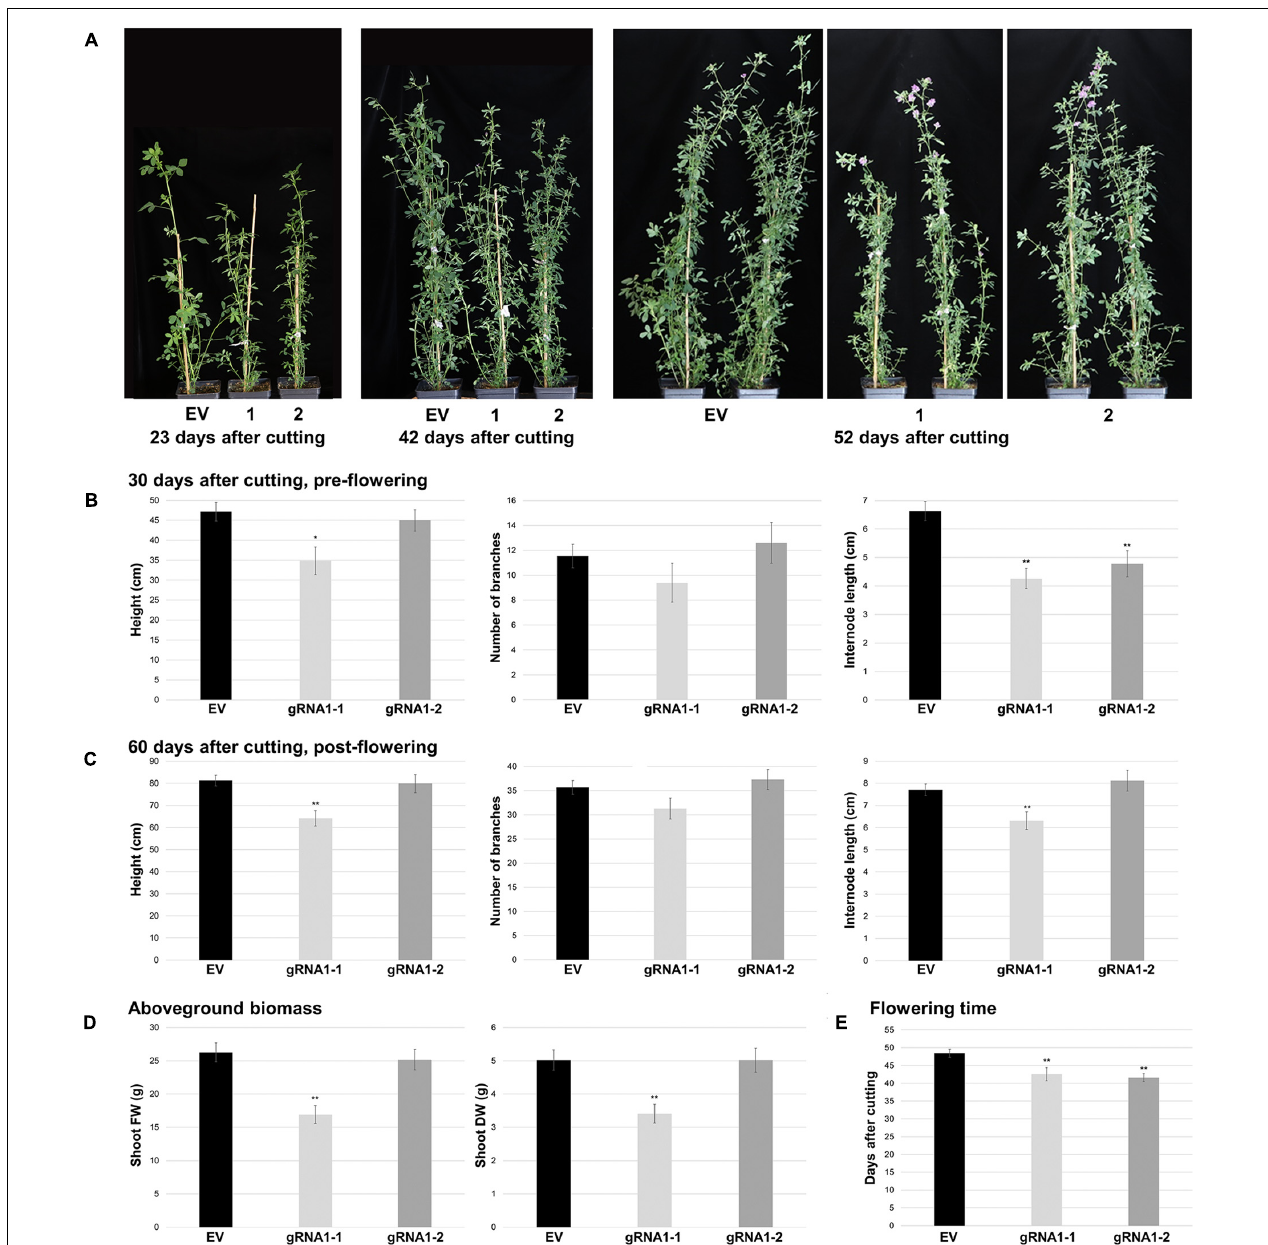
FIGURE 4 | Aboveground growth characteristics of SPL8-gRNA1 and EV control genotypes. (A) Representative images are of edited SPL8-gRNA1-1 (1) and SPL8-gRNA1-2 (2) genotypes, as well as EV controls, 23, 42 and 52 days following cutting. (B,C) Graphs depict plant height, total number of branches and internode length 30 (B) and 60 (C) days after cutting. (D) Shoot fresh weight (FW) and dry weight (DW) 60 days after cutting when all plants were flowering. (E) Number of days following cutting at which plants began to flower. For all graphs, each block represents the mean of five SPL8-gRNA1-1 (gRNA1-1), five SPL8-gRNA1-2 (gRNA1-2) and fifteen EV (five each of three independent transformants) biological replicates (B) or ten SPL8-gRNA1-1 (gRNA1-1), ten SPL8-gRNA1-2 (gRNA1-2) and thirty EV (ten each of three independent transformants) (C–E) biological replicates derived from stem cuttings, while bars denote standard errors. Asterisks denote means that are significantly different from EV controls as determined by 2-tailed student’s t -tests assuming unequal variance (* P ≤ 0.05; ** P ≤